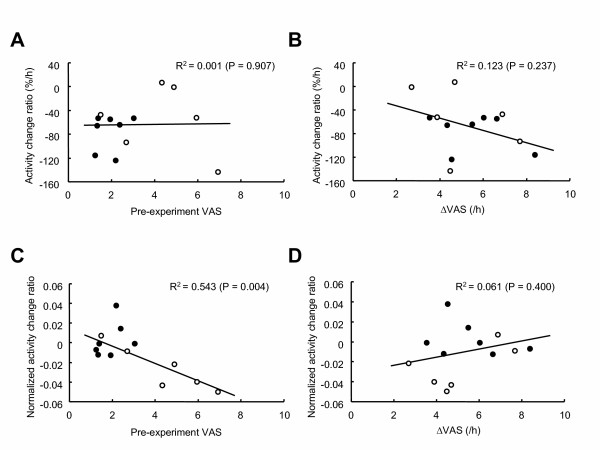
Subjective-activity correlations. Subjective scale correlations for the signal changes of the visual (A, B) and auditory (C, D) cortices are shown. Activity change rate or normalised activity change ratio were plotted against pre-experiment visual analogue scale score (pre-experiment VAS) (A, C) or change rate of visual analogue scale score after the experiment (ΔVAS) (B, D). Activity change rate was calculated as change of activity of the visual cortices during the visual search from pre-fatigue to post-fatigue sessions divided by the session time (hour) of the fatigue-inducing period. Normalised activity was calculated as activity of the auditory cortices in a given section divided by that in the first section. Normalised activity change ratio was calculated from the slope of regression fitted to a scatter plot of the time course (section) against normalised activity. Subjects were asked to rate subjective sensation of fatigue on the VAS from 0 to 10. Squared Pearson correlation (R2) and P value are displayed. Closed circles, normal subjects; open circles, CFS subjects.